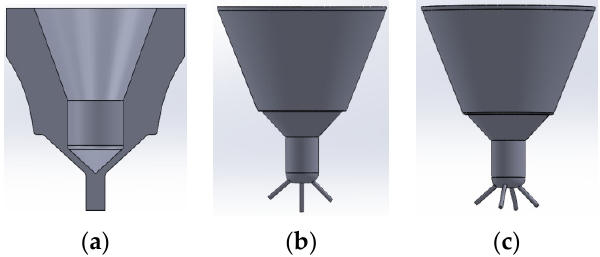
Figure 2. A diagram of fluid in nozzles: ( a ) single hole, ( b ) 3-holes, ( c ) 4-holes.